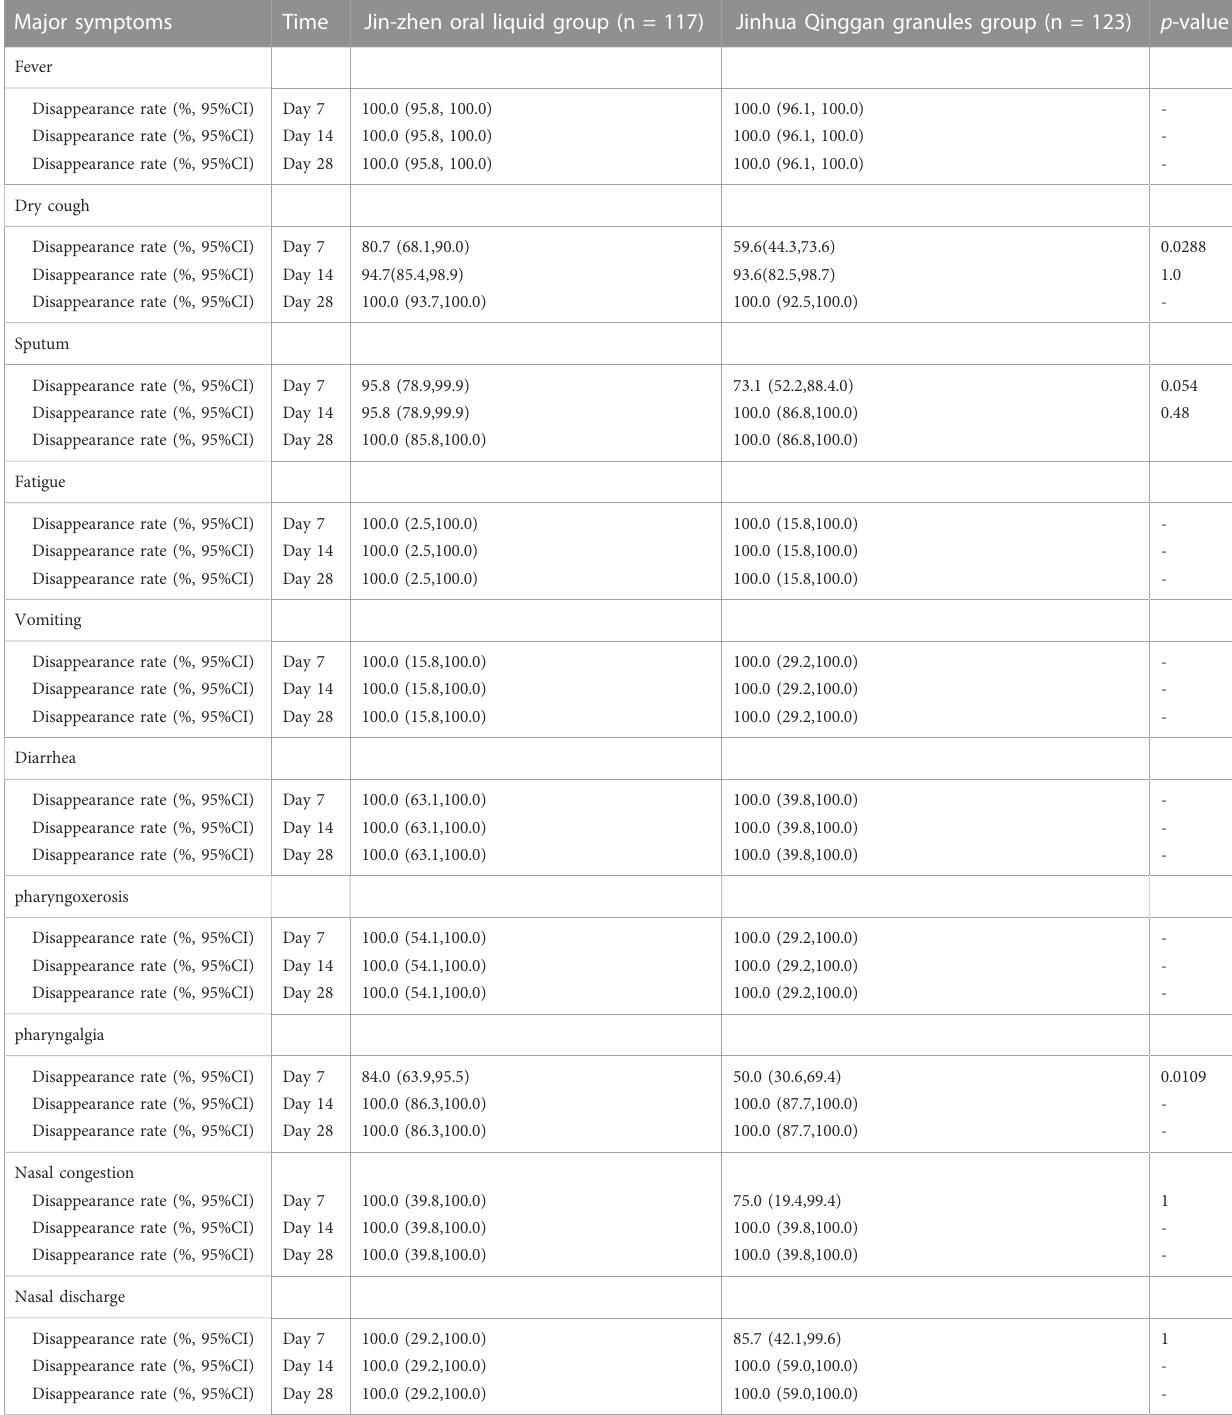
TABLE 4 The rate of major symptoms disappearance at day7, 14 and 28